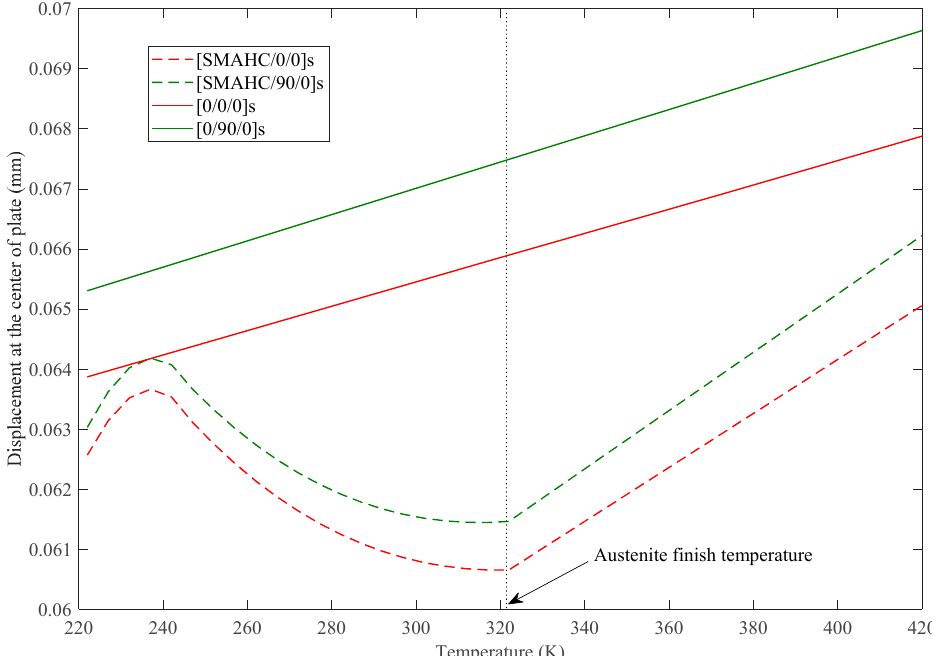
Figure 5. Static deflection at the center of the plate vs. temperature, with Vs = 30%, ε = 5%, CCCC boundary